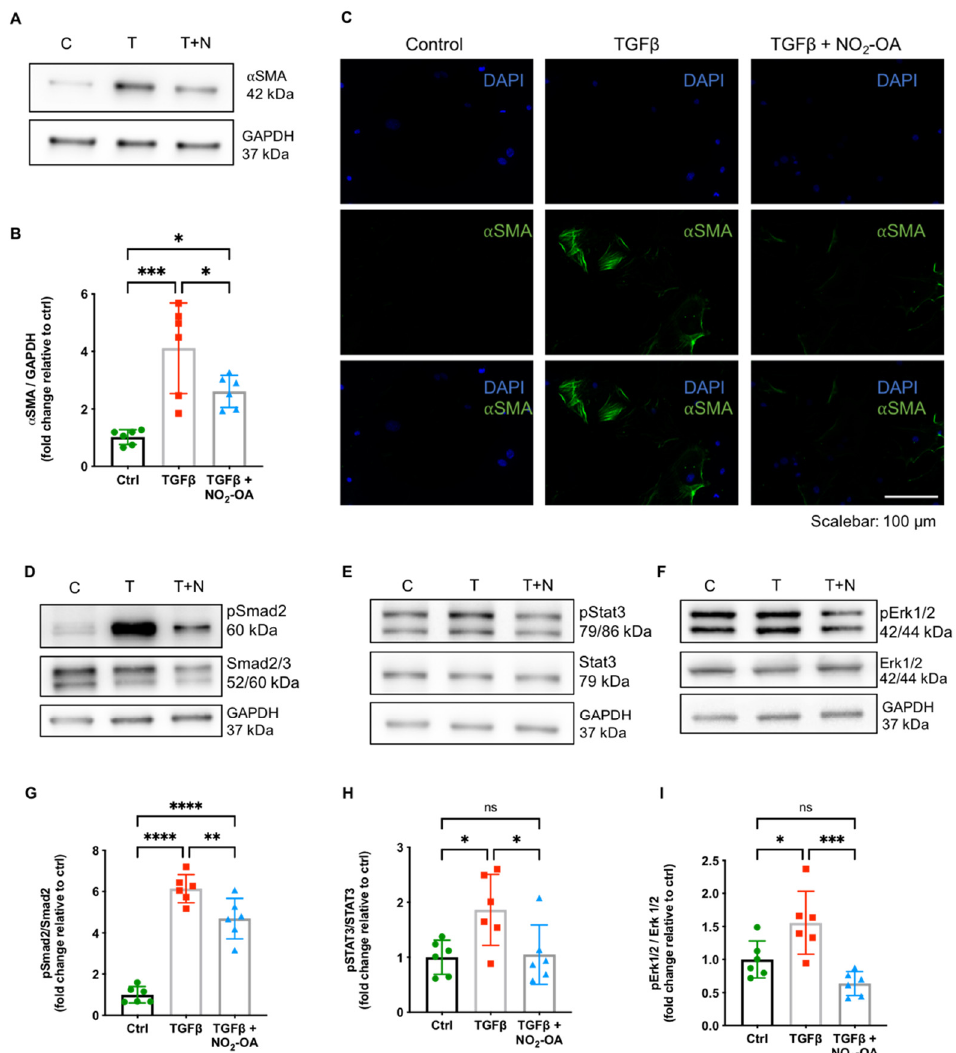
Figure 4. Effect of NO 2 -OA on TGF β signaling in isolated primary cardiac fibroblasts. Representative ( A ) immunoblots, ( B ) quantification for expression of α SMA, and ( C ) representative immunofluorescence show an increased α SMA expression in cardiac fibroblasts upon treatment with TGF β , which is significantly attenuated by concomitant treatment with NO 2 -OA. Protein expression analysis of the phosphorylation ratio of Smad2 ( D , G ), Stat3 ( E , H ), and Erk1/2 ( F , I ) revealed attenuated phosphorylation by NO 2 -OA. Data are expressed as mean ± SD, * p < 0.05, ** p < 0.01, *** p < 0.001, **** p < 0.0001, one-way ANOVA with Tukey multiple comparison test, n = 6 as indicated, scalebar as